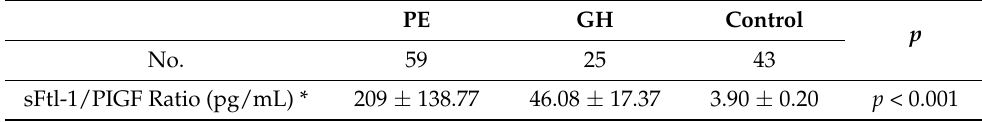
Table 3. Specific values of the sFtl-1/PIGF ratio in the studied groups. PE